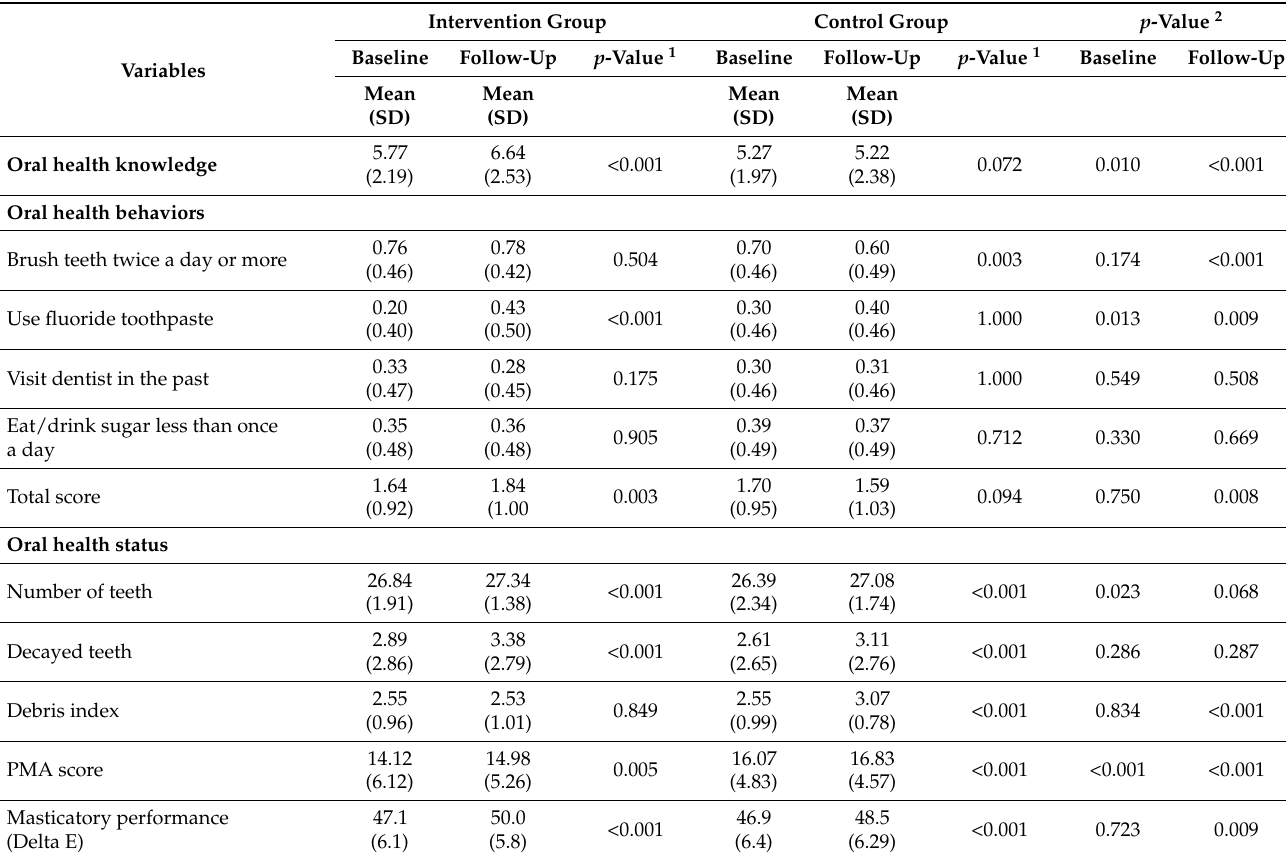
Table 2. Oral health knowledge, behaviors, and clinical status in intervention and control groups, at baseline and at follow-up. Intervention Group Control Group p -Value 2 Baseline Follow-Up p -Value 1 Baseline Follow-Up p -Value 1 Variables